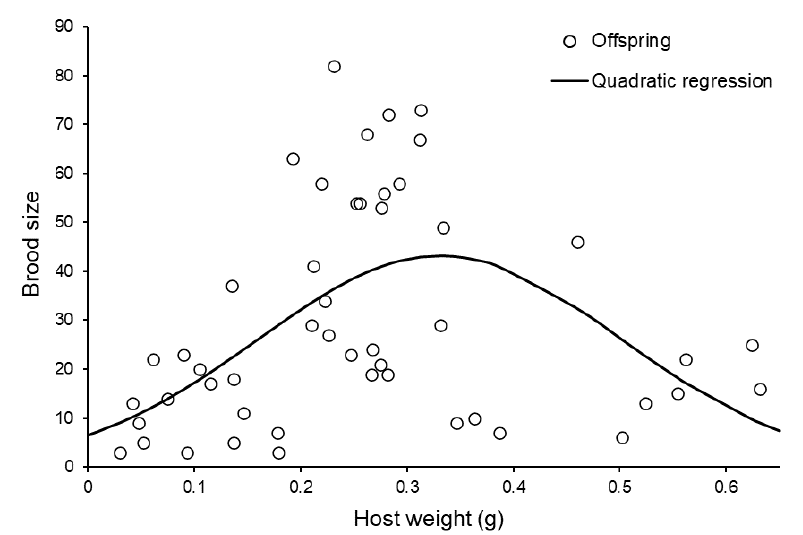
Figure 2. The number of offspring produced by individual Sclerodermus brevicornis females according to the size of the host presented. The fitted curve was estimated using log-linear regression including a quadratic term (brood size = antiLog e ((11.37 × Host weight) + ( − 17.19 × Host weight 2 ) + 1.887)). 3.3. Longevity of Sclerodermus brevicornis Females Stored at Di ff erent Temperatures Some S. brevicornis lived almost 100 days, but longevity was strongly temperature